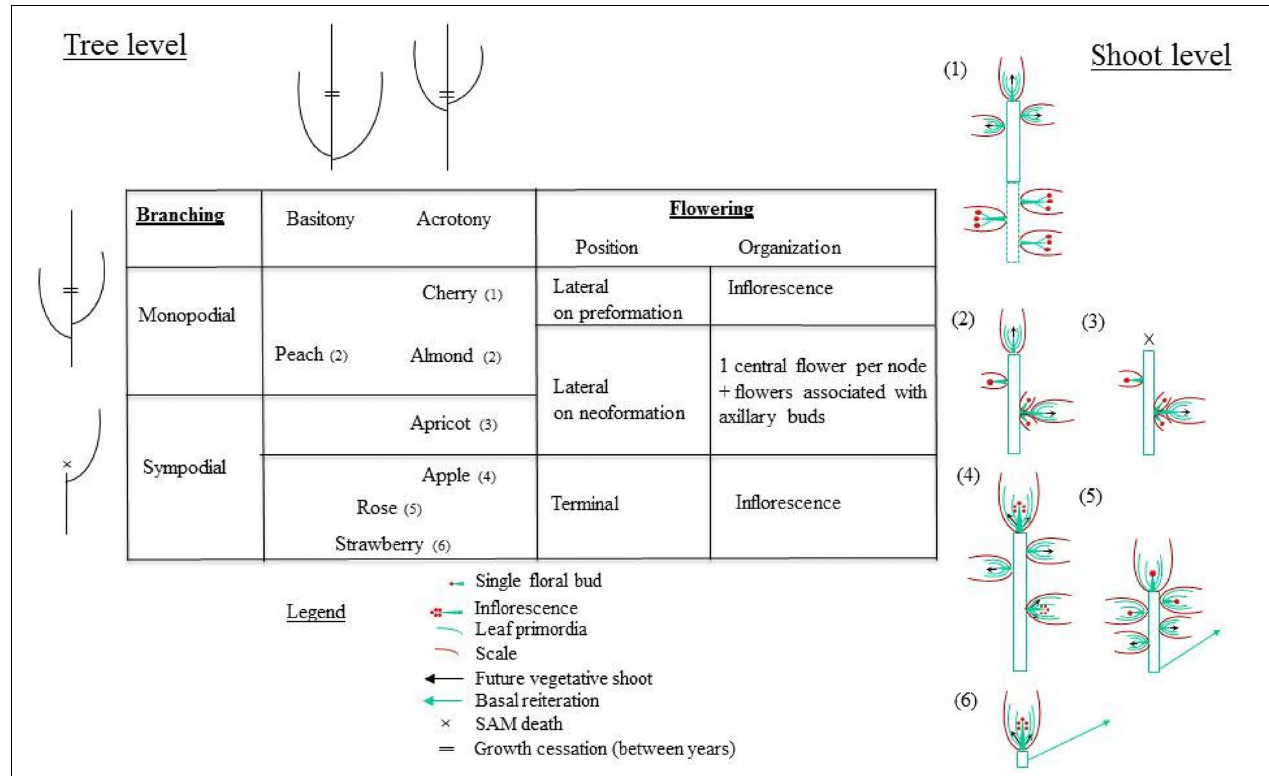
FIGURE 6 | Synthesis of the branching organization at the tree and shoot scales, in relation to vegetative and reproductive bud position and internal structure, in a range of Rosaceae